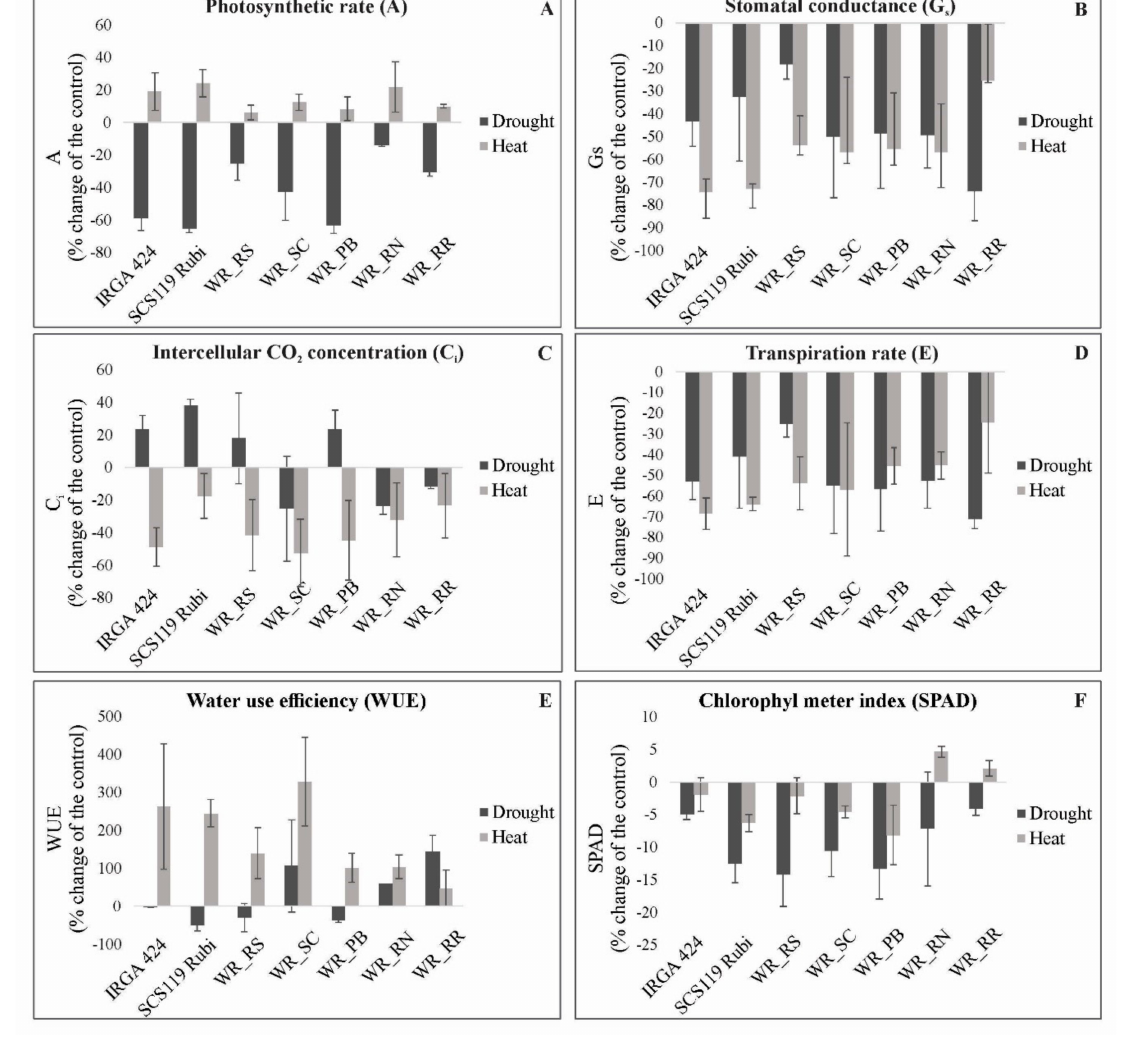
Figure 3. Photosynthetic parameters in rice and weedy rice genotypes in drought and heat stress conditions. Photosynthetic rate (A) ( A ); Stomatal conductance (G s ) ( B ); Intercellular CO 2 concentration (C i ) ( C ); Transpiration rate (E) ( D ); Water use efficiency (WUE) ( E ) and Chlorophyll meter index (SPAD) ( F ). Means followed by different uppercase letters are different based on Tukey’s test ( p < 0.05). Error bars represent 95% confidence